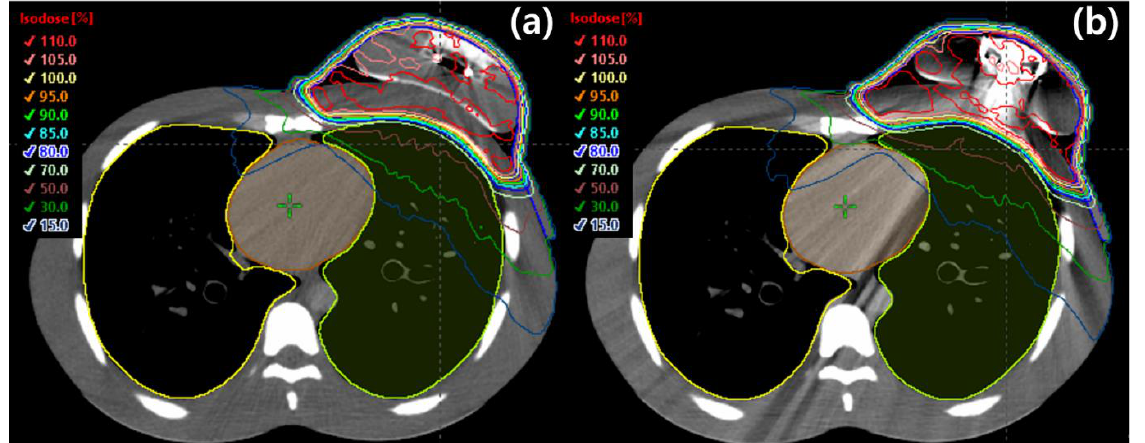
Figure 4. The dose distributions for the radio frequency identification ports and metallic ports in axial view. The isodose lines correspond to 110% (red), 105% (pink), 100% (yellow), 95% (orange), 90% (green), 85% (cyan), 80% (blue), 70% (light green), 50% (brown), 30% (dark green), and 15% isodose (dark blue). ( a ) RFID port; ( b ) metallic port.